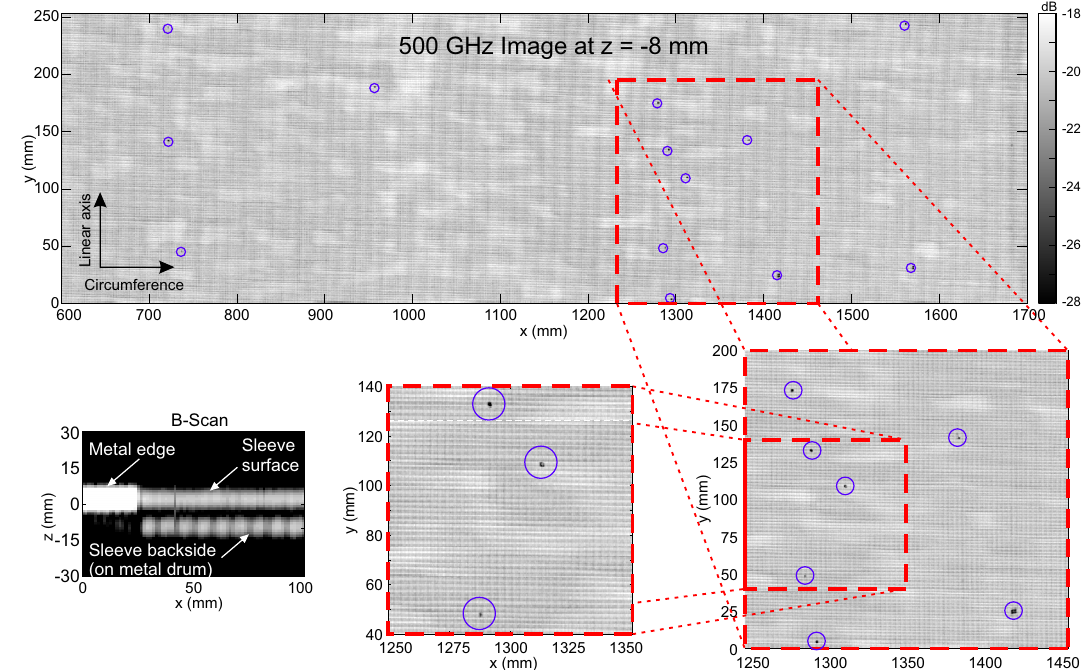
Figure 6. Terahertz image (C-scan) of a larger segment (1100 × 250 mm 2 ) of a press sleeve measured at the production site as in Figure 5 with the 500 GHz transceiver at 20 kHz measurement rate. The image shows a depth layer close to the sleeves backside in contact with the metal barrel (see B-scan in lower left corner) at 8 mm below the surface. The magnified images indicate that the size of most of the defects is comparable to the grid generated by the sleeve’s fiber mesh inlay roughly amounting to approximately 1 mm in diameter or